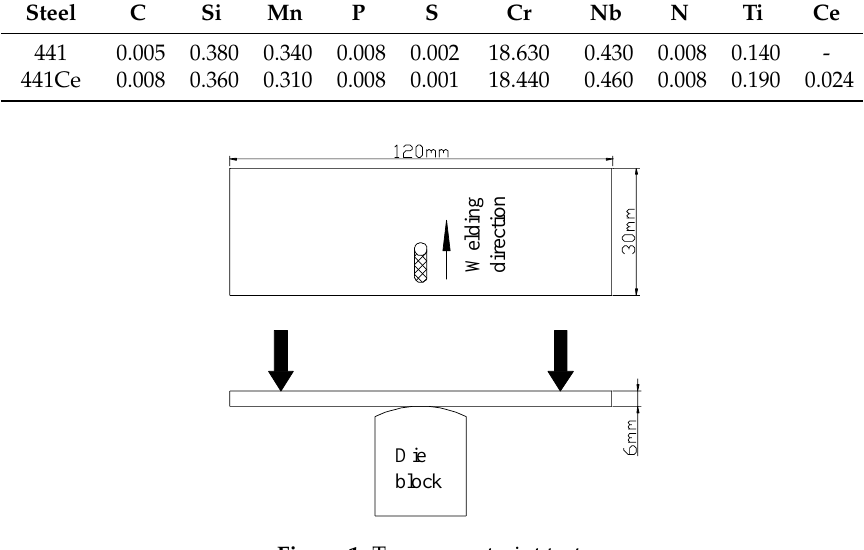
Figure 1. Trans-varestraint test.